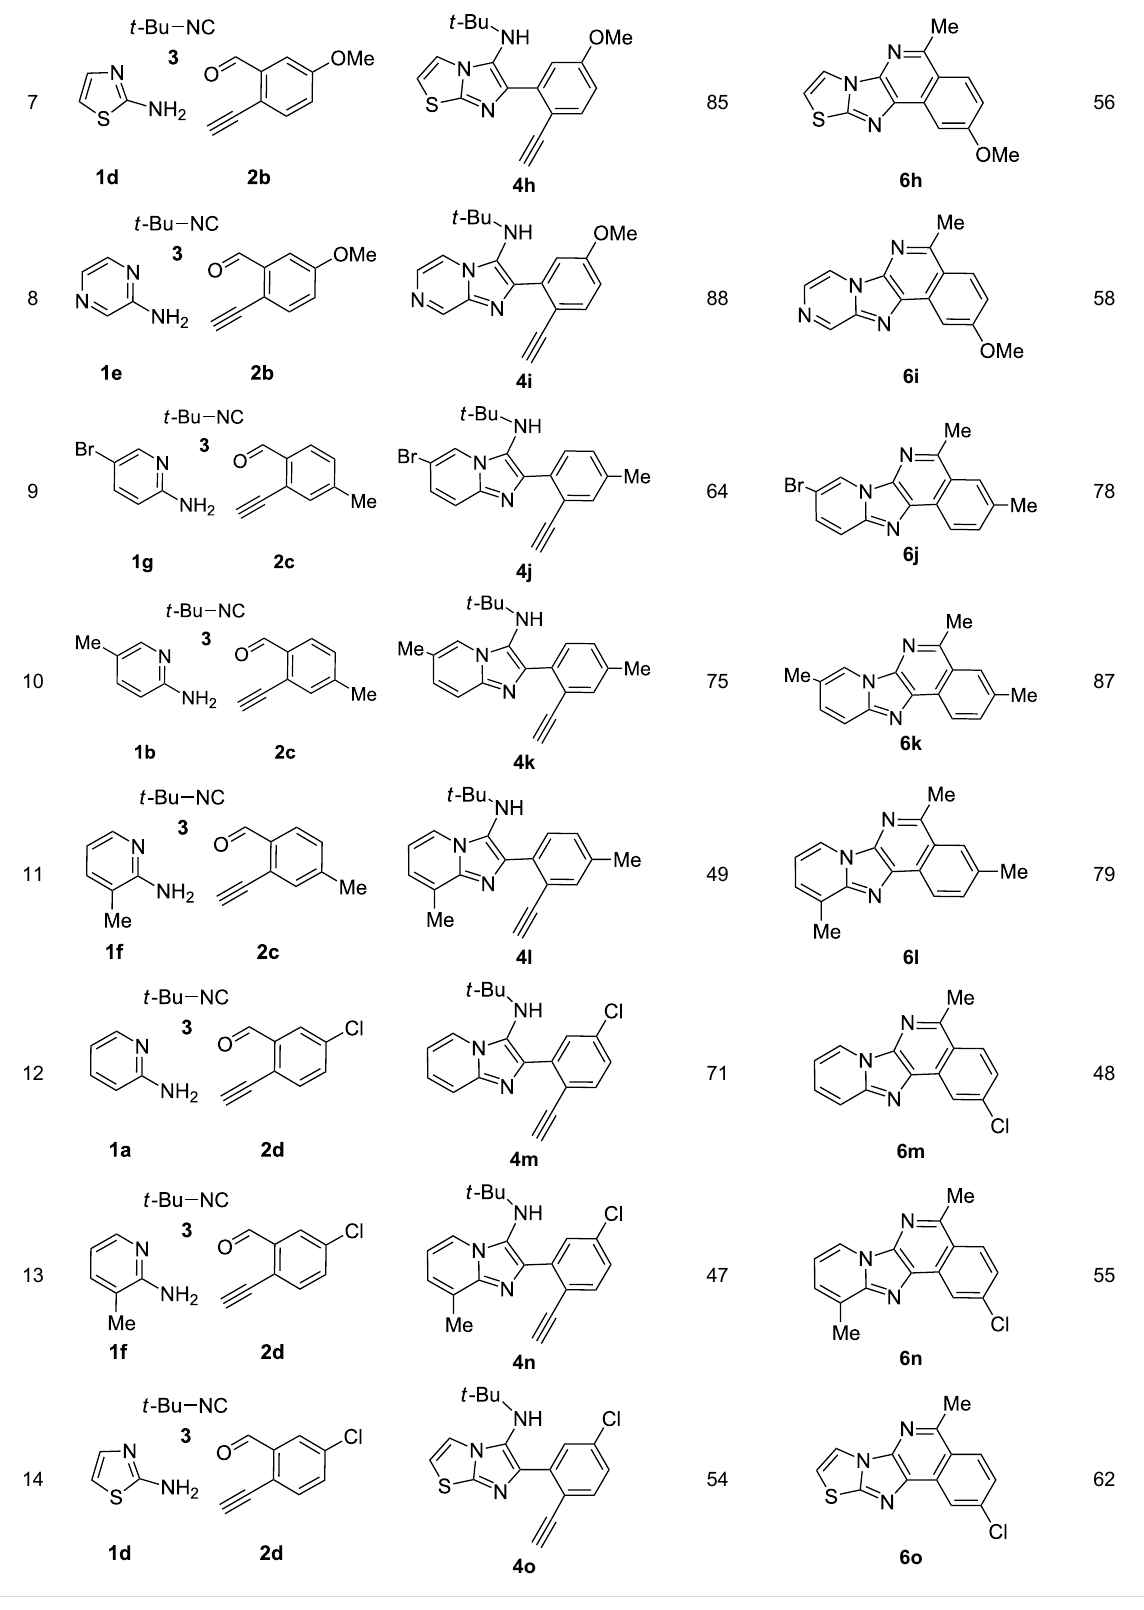
Table 2: Substrate scope for the syntheses of compounds 4 and 6 . a